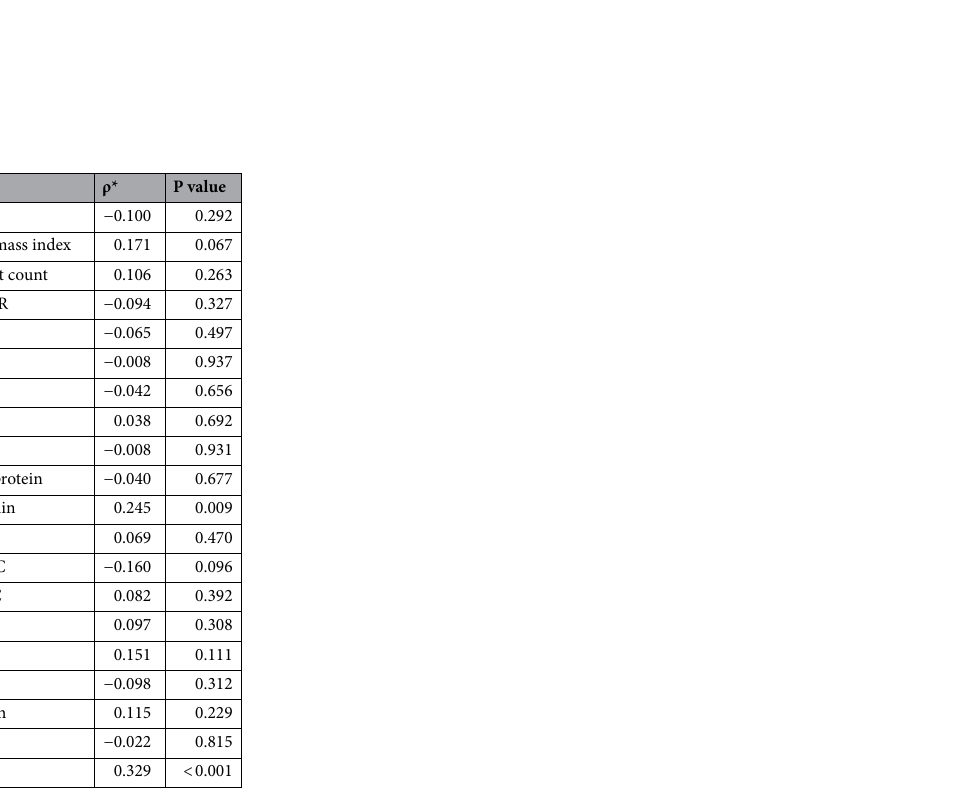
Table 2. Correlations of various parameters with CAP. PT-INR, prothrombin time–international normalized ratio; AST, aspartate aminotransferase; ALT, alanine aminotransferase; ALP, alkaline phosphatase; γGT, γ-glutamyl transpeptidase; T-BIL, total bilirubin; TC, total cholesterol; HDL-C, high-density lipoprotein cholesterol; LDL-C, low-density lipoprotein cholesterol; TG, triglycerides; FPG, fasting plasma glucose; T4C7s, type IV collagen 7 s; SCD, skin–capsular distance. *Spearman’s correlation